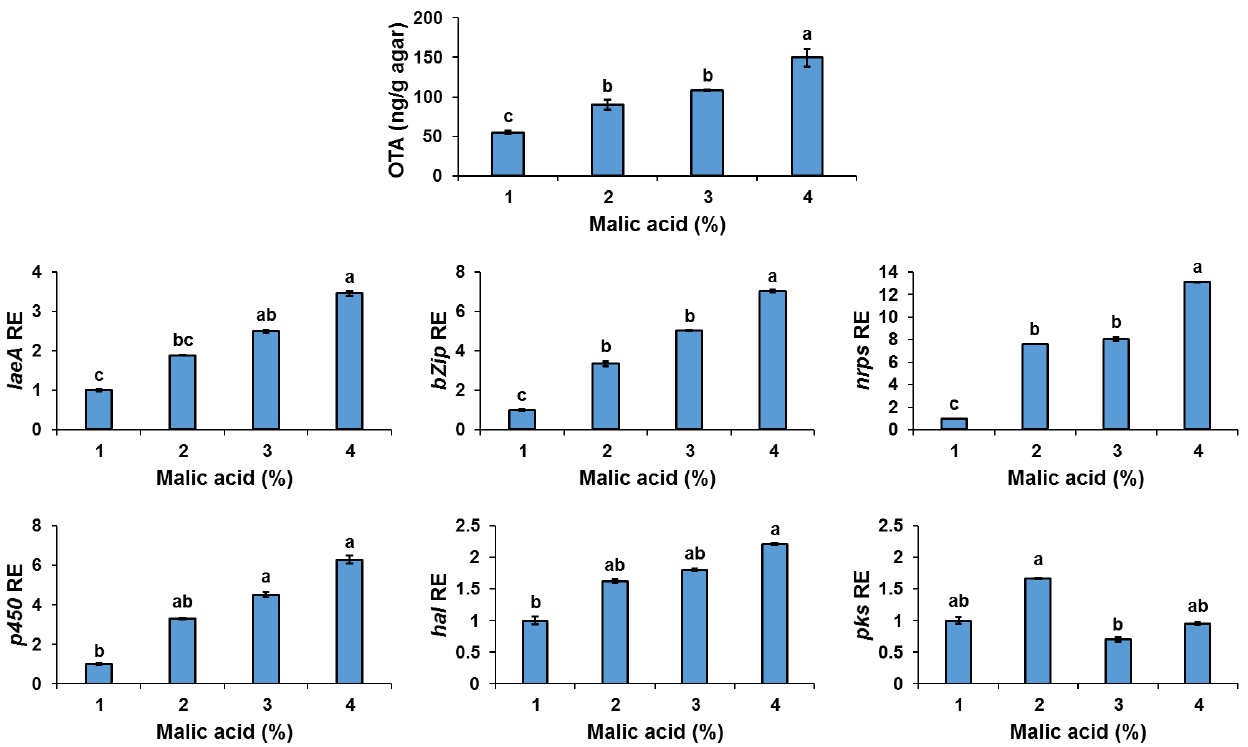
Figure 4. Effect of malic acid on OTA synthesis by A. carbonarius in SGM media. Solid SGM-media was supplemented with 1–4% concentrations of malic acid and inoculated with 100 µ L of a 10 6 spore/mL. OTA accumulation and relative expression of laeA and OTA gene cluster were evaluated 6 days post-inoculation. Relative expression was normalized using β -tubulin as an internal control. Error bars represent a standard error of three independent biological replicates. Different letters above the columns indicate statistically significant differences at p < 0.05, as determined using the Tukey’s honest significant difference test.